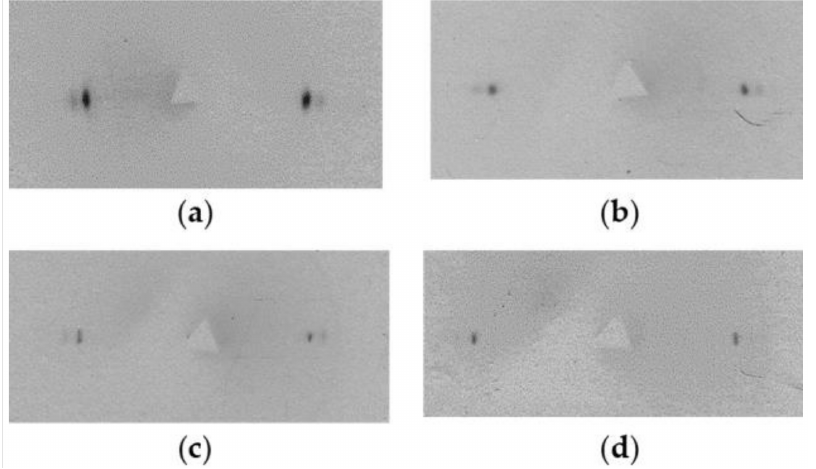
Figure 12. 2D-WAXS patterns for the oriented UHMWPE films obtained from a 1.5% solution in decalin with the values of the degree of drawing: ( a ) λ = 14; ( b ) λ = 63; ( c ) λ = 89 and ( d ) λ = 119. Orientation of the samples was